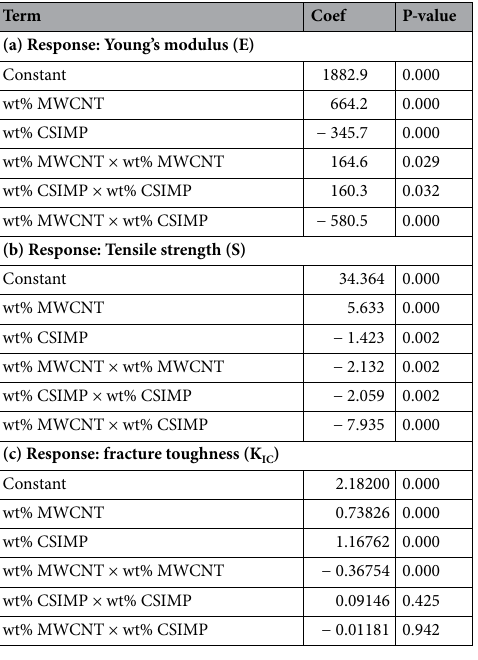
Table 3. Analysis of variance for the models and estimated regression coefficients. (a) R-Sq = 98.4%, R-Sq(adj) = 97.2%, P-value of Lack-of-Fit = 0.073, P-value of Regression = 0.000. R-Sq = 98.9%, R-Sq(adj) = 98.1%, P-value of Lack-of-Fit = 0.846, P-value of Regression = 0.000. (c) R-Sq = 98.2%, R-Sq(adj) = 97%, P-value of Lack-of-Fit = 0.113, P-value of Regression =